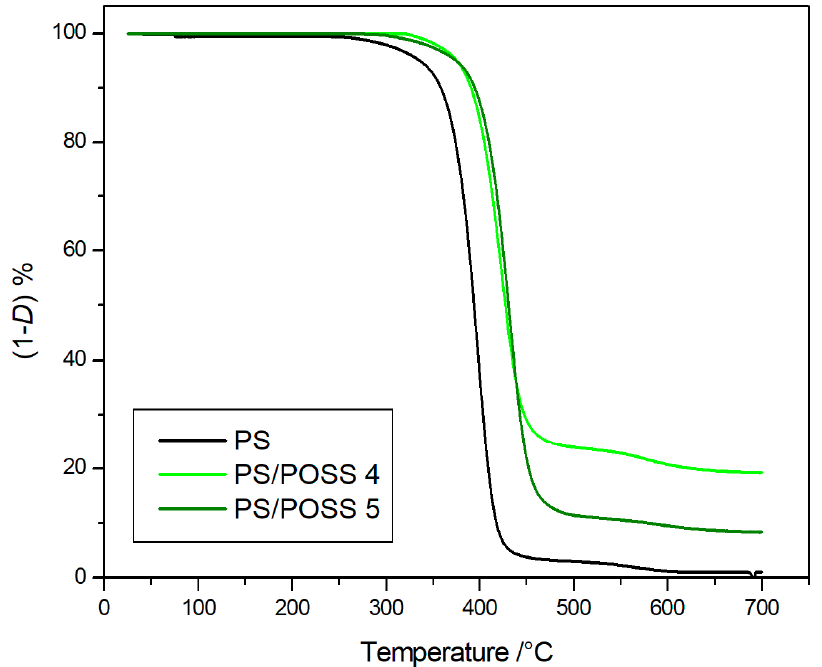
Figure 3. Thermogravimetric curves, in an inert atmosphere, for PS and samples 4 and 5 .